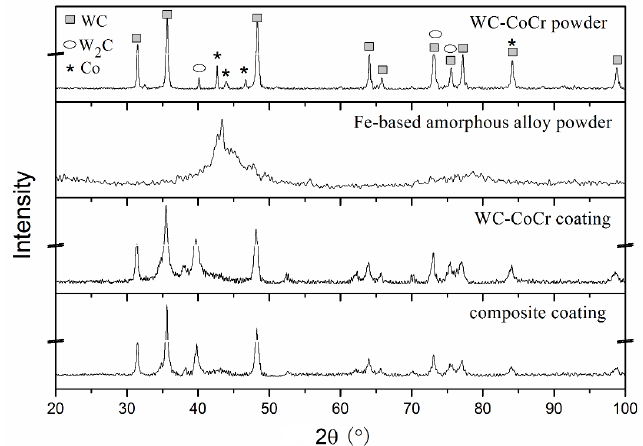
Figure 2. XRD patterns of WC – CoCr powder, Fe-based amorphous alloy powder, WC – CoCr coating, and composite coating.